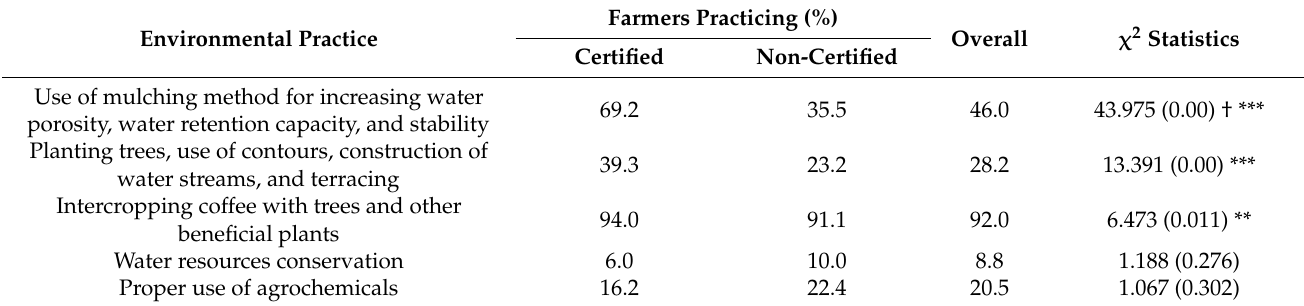
Table 5. Environmental conservation practices among coffee